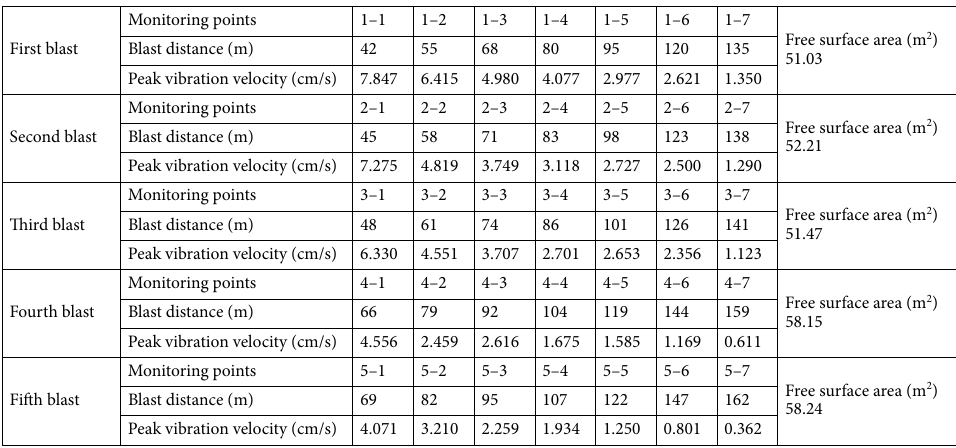
Table 2. Site blasting vibration velocity monitoring